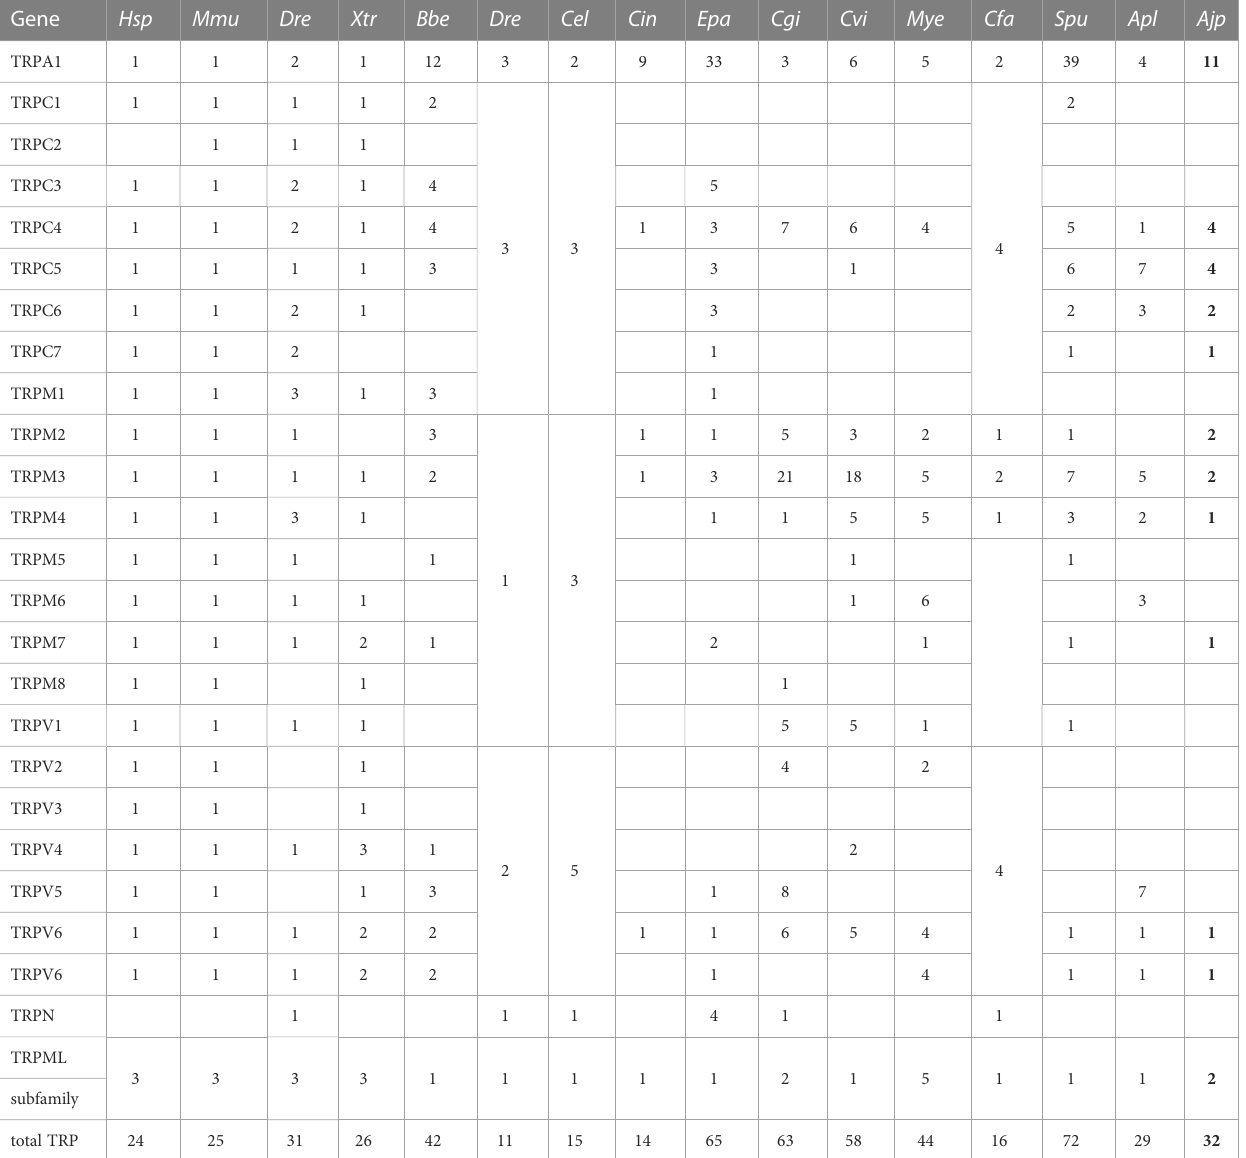
TABLE 1 Copy Numbers of TRP Genes in A. japonicus and other representative